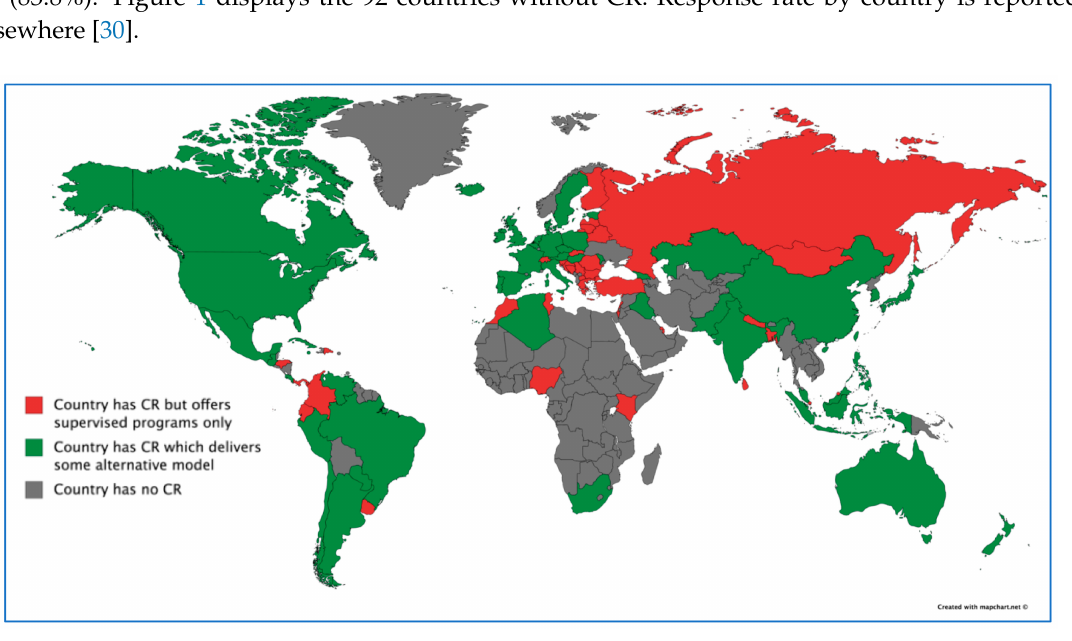
Figure 1. Countries That Offer Any Alternative Models of Cardiac Rehabilitation around the Globe. CR = cardiac